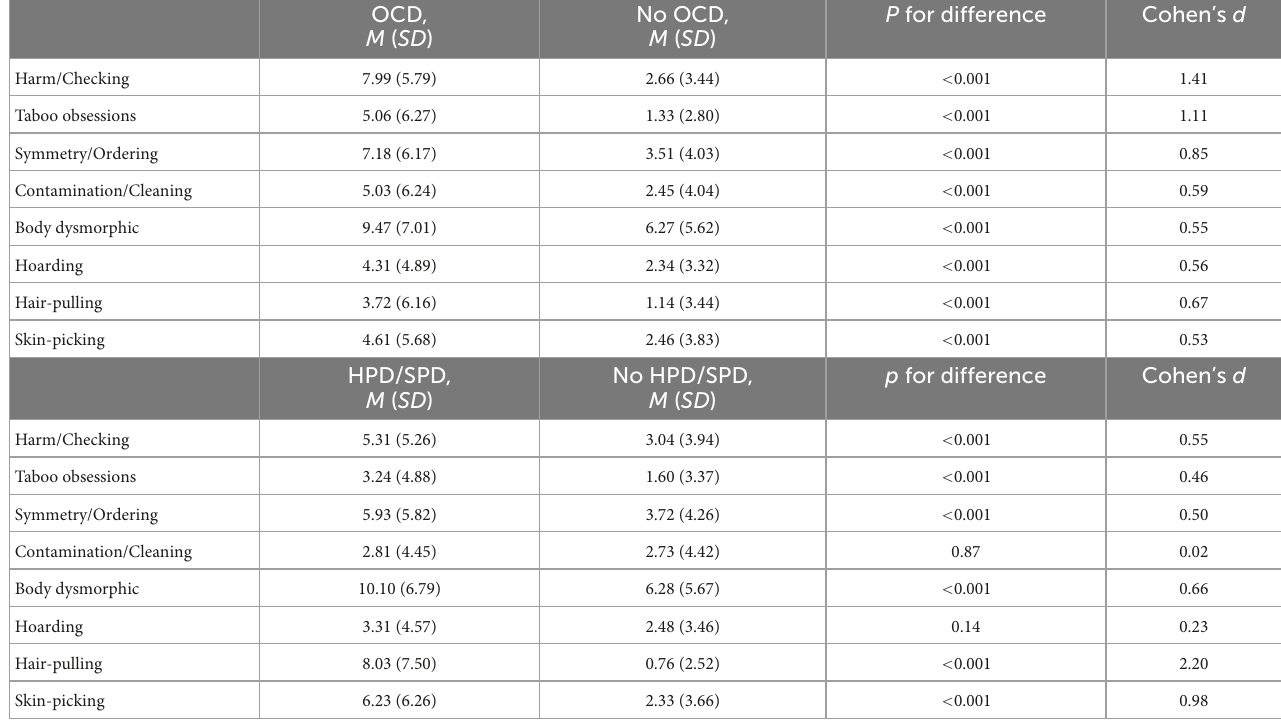
TABLE 3 Differences on the OCRD-D-E for those with vs. without a lifetime history of an OCD diagnosis and those with vs. without a lifetime history of an HPD/SPD